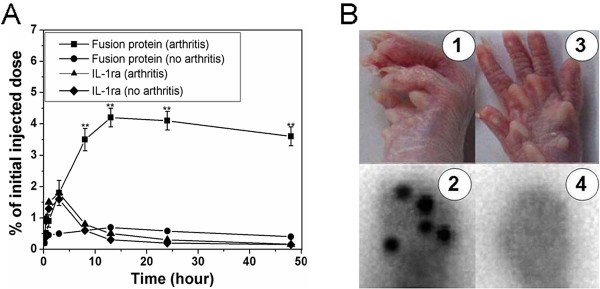
(A) Uptake kinetics of131I-labeled fusion protein and131I-labeled IL-1ra in hind paws of mice with (n = 5) and without CIA (n = 5) after intravenous injection. Data are expressed as mean ± SEM. ** = p < 0.01 versus uptake rates of 131I-labeled IL-1ra in hind paws of arthritic mice or healthy mice and uptake rates of 131I-labeled fusion protein in hind paws of healthy mice. (B) Autoradiogram for the selectively accumulation of the fusion protein in the inflamed joint of mice. (1) and (2), inflamed paw; (3) and (4), normal paw.